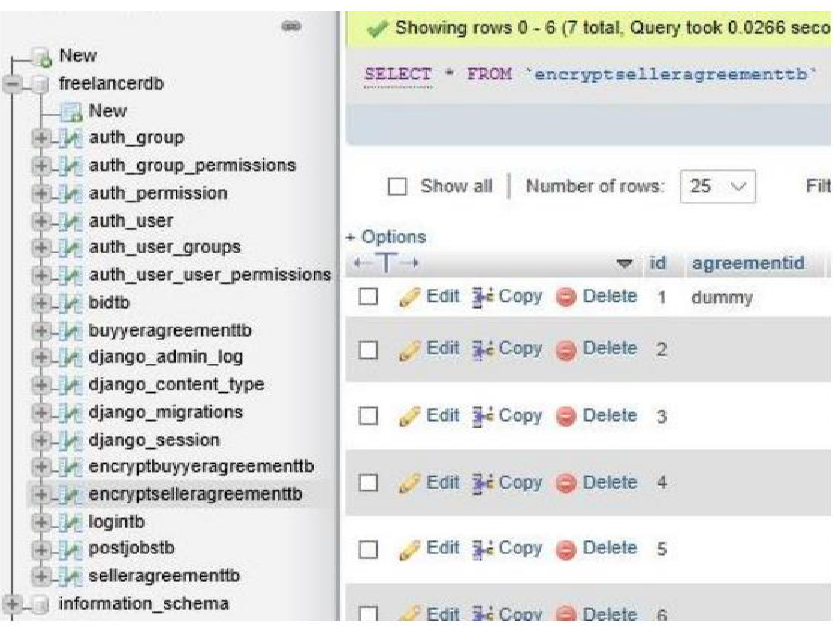
Figure 6. Backend connected database design of the system.